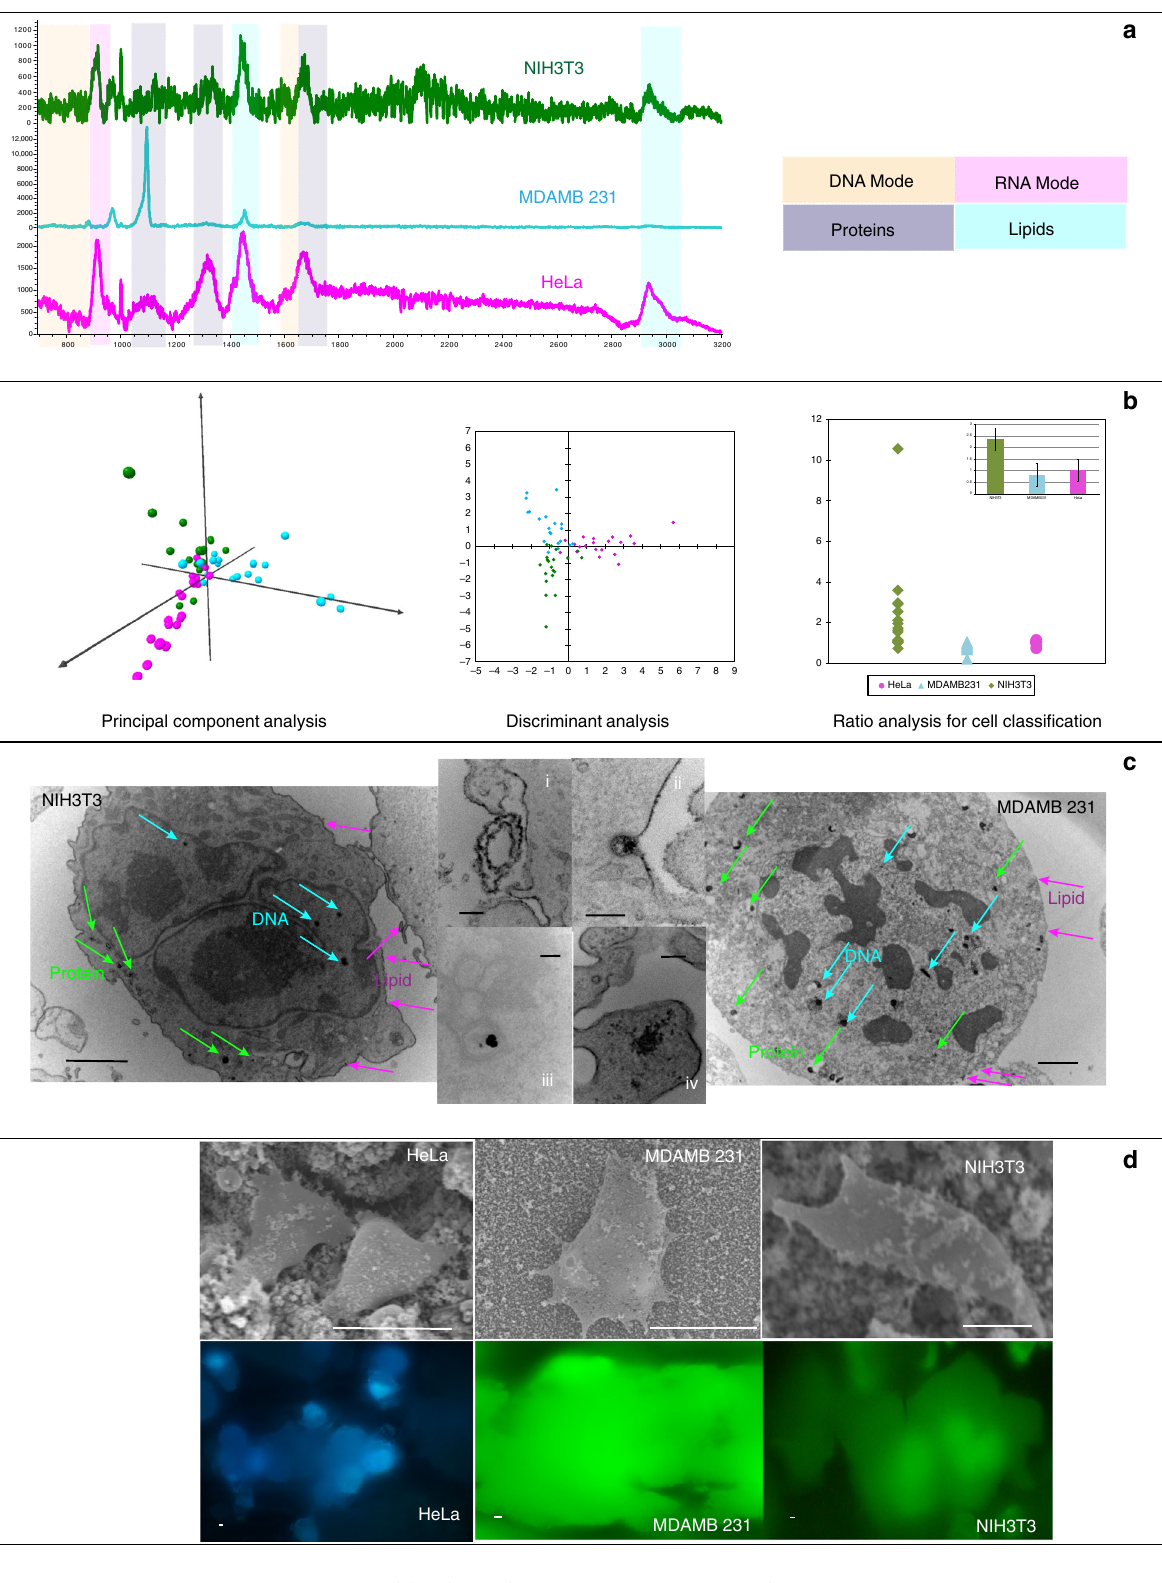
were fabricated. EzCAD software in combination with piezo-driven scanner was used for plotting the array. Different scanning speeds and repetition rates